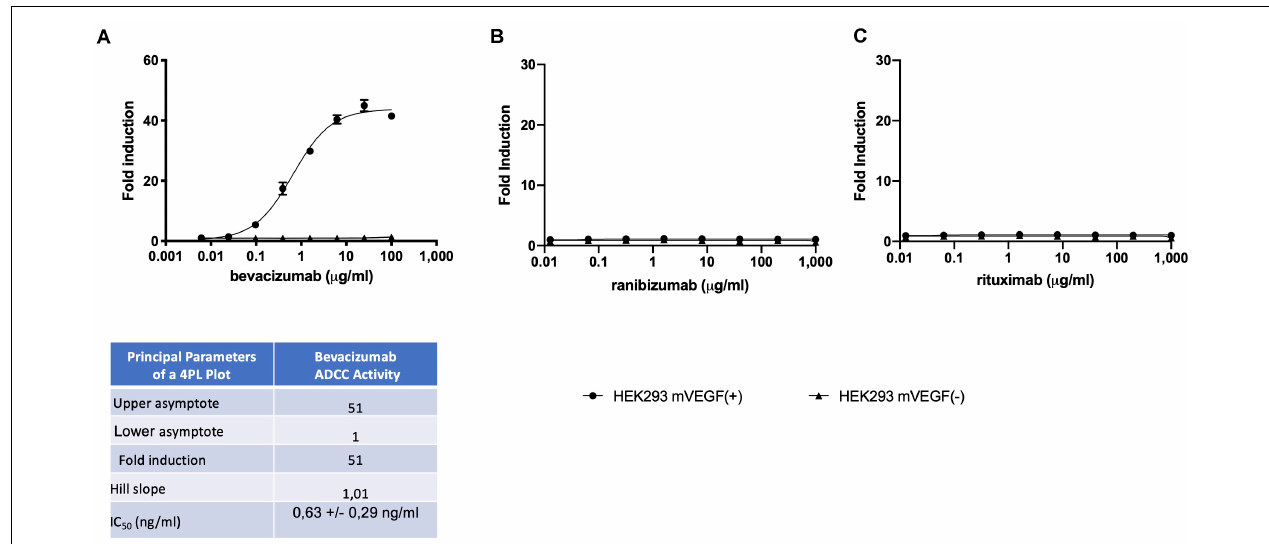
FIGURE 3 | ADCC effector cells (E) at a concentration of (1.2 × 10 5 cells/well), were incubated with mVEGF (+) or mVEGF( − ) target cells (T) at an E:T ratio of 3:1 and increasing concentrations of bevacizumab (A) ranibizumab (B) , or rituximab (C) for 4 h prior to the quantification of FL activity as described in the section “Materials and Methods”. The associated Table to the Figure shows the principal parameters of a 4PL plot of fold-induction of the ADCC activity of bevacizumab determined using the Prism software. To eliminate possible non-specific effects, the ADCC activity of each serum sample was first determined by interpolation of the standard curve of bevacizumab activity determined using both mVEGF (+) and mVEGF( − ) target cells and the values obtained in the presence of the mVEGF( − ) target cells were subtracted from those obtained using the mVEGF (+) terget cells and using the Prism software (GraphPad,